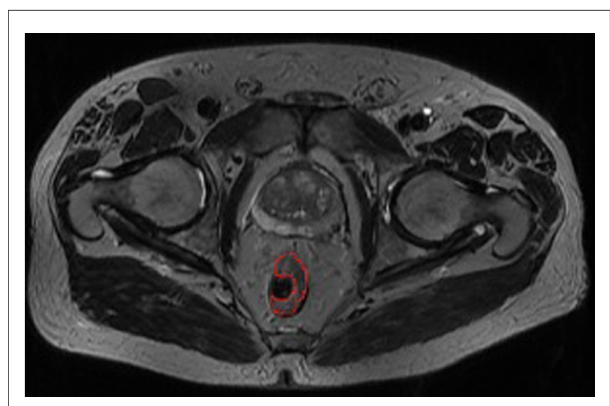
FIGURE 1 Entire tumor margins marked (red) — one of three marked transverse images for semiautomated volume measurement using mint lesion TM